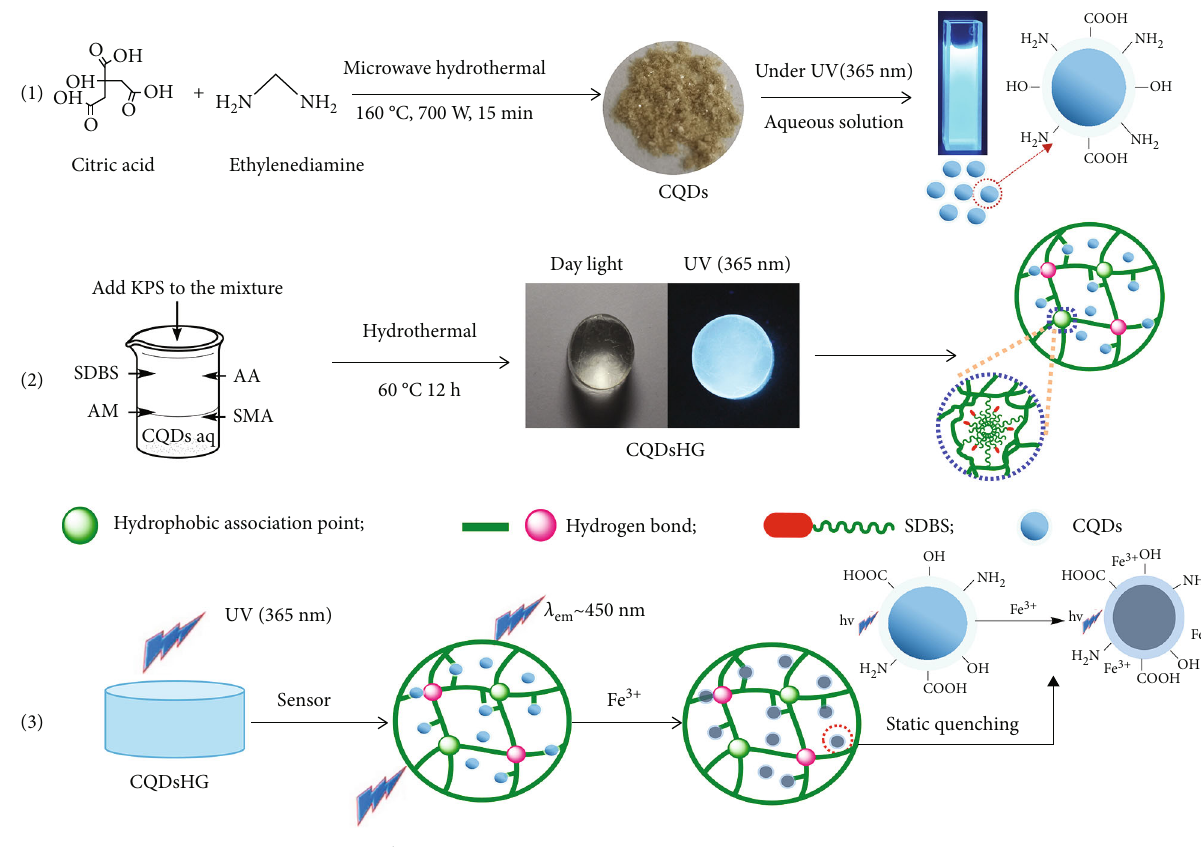
Figure 1: Schematic showing (1) the preparation of the CQDs, (2) preparation of the CQDsHG, and (3) action mechanism of the CQDsHG as a sensor for Fe 3+